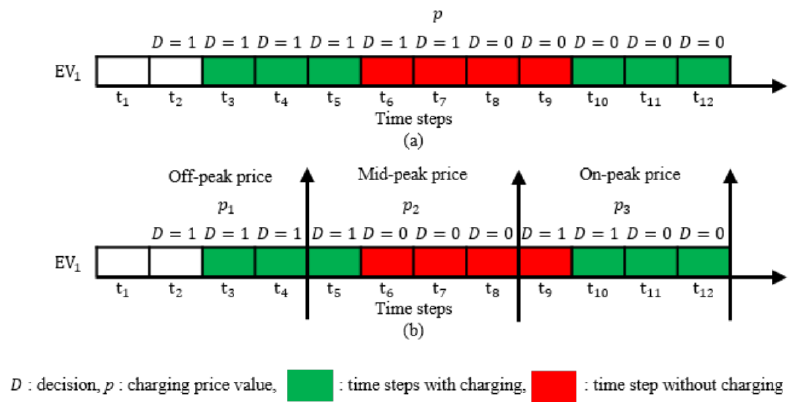
Figure 2. Illustration of charging process and the cost. ( a ). Standard tariff with flat rate ( b ). Different time-of-use (TOU) tariff